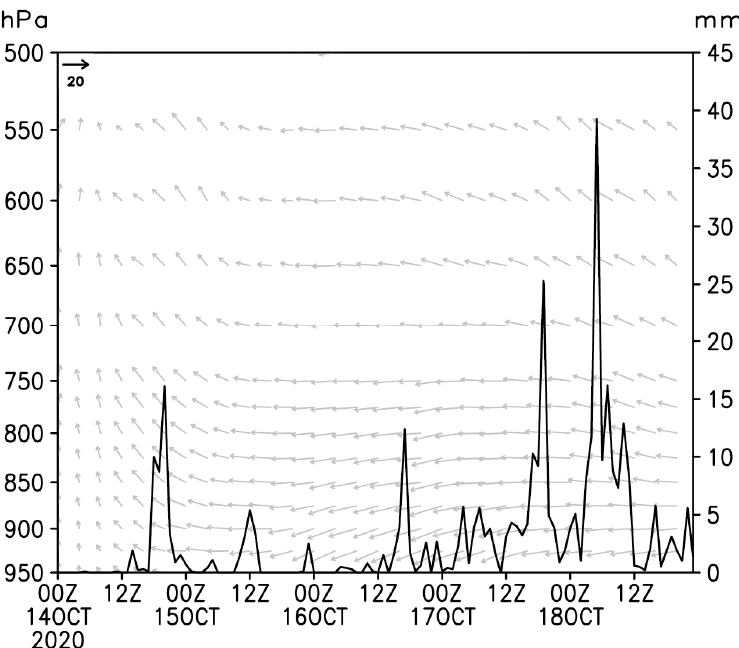
Figure 6. Pressure-time profile of horizontal wind (units: m · s − 1 ) overlaid with hourly precipitation (units: mm · h − 1 ) at Sanya (denoted by blue triangle in Figure 1d).